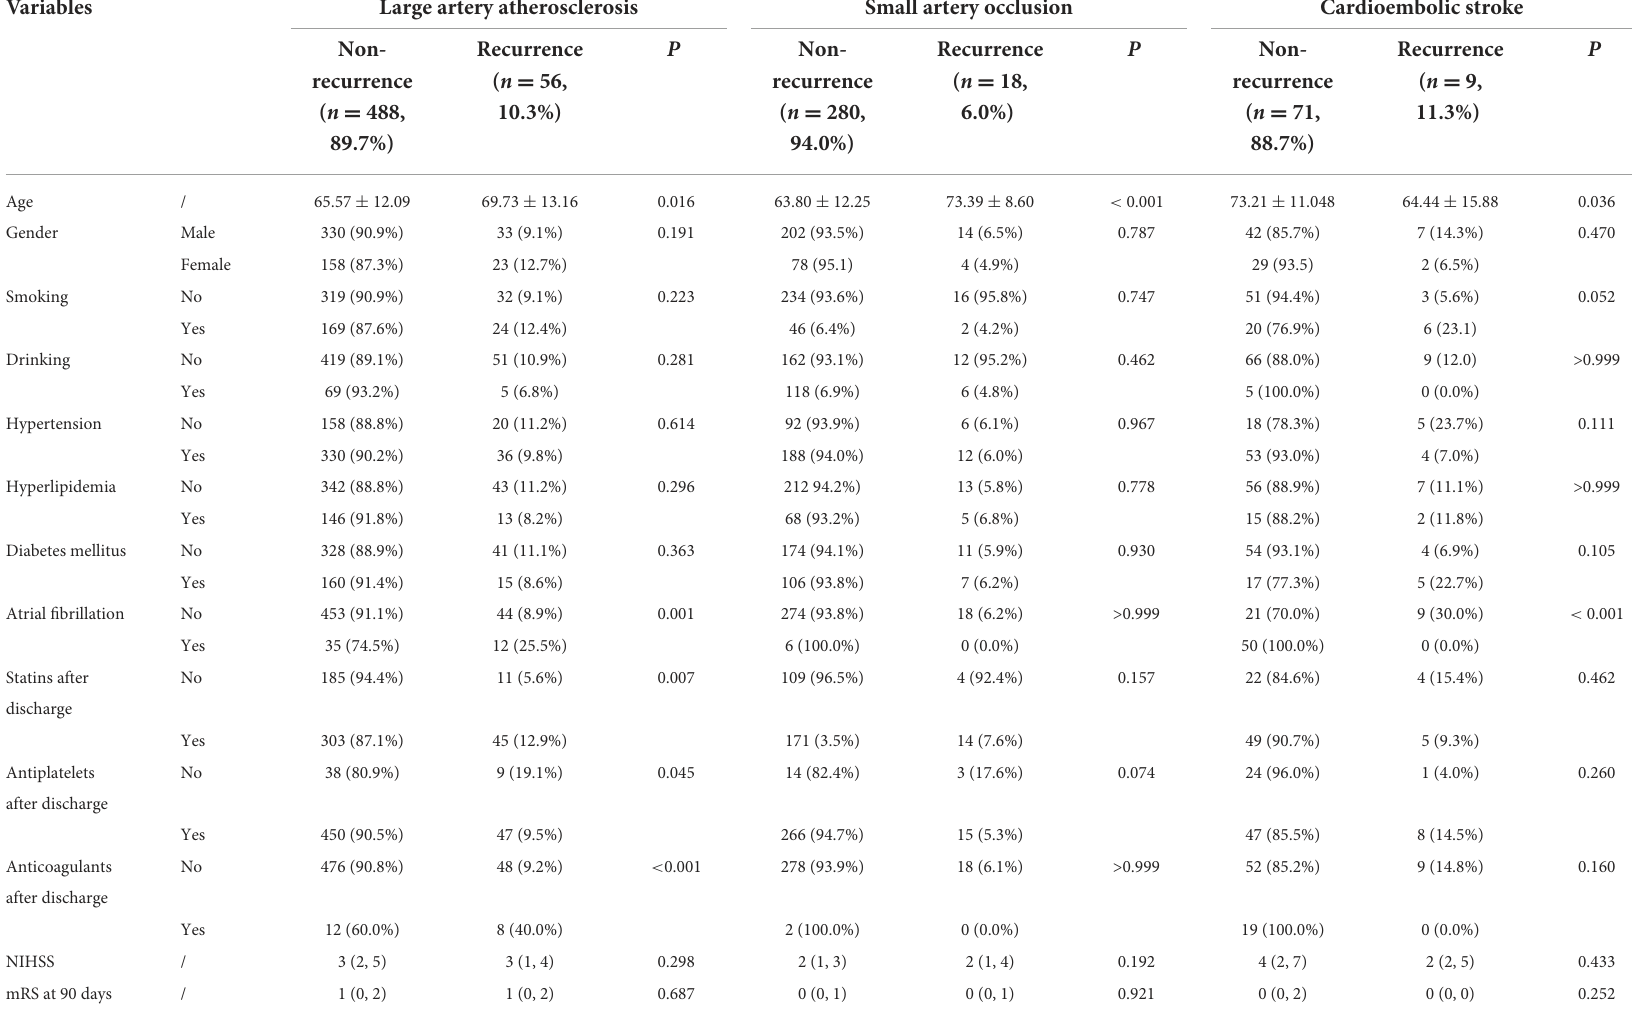
TABLE 2 Demographic and clinical characteristics of different ischemic stroke subtypes